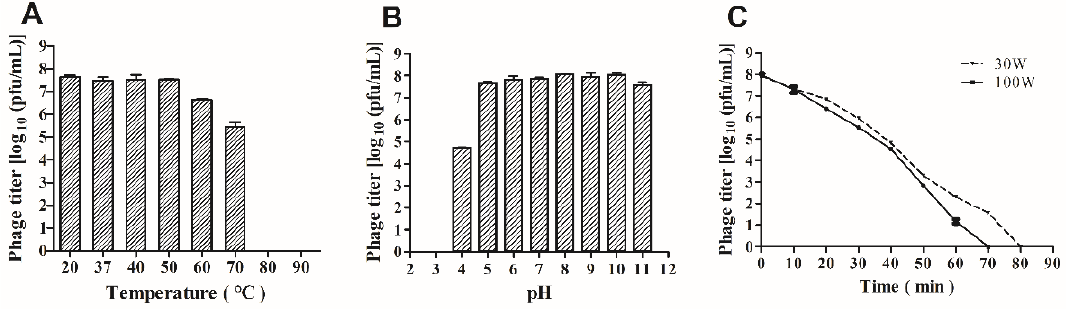
Figure 3. Stability of vB_VpaP_GHSM17 at ( A ) pH; ( B ) temperatures; and ( C ) UV values.